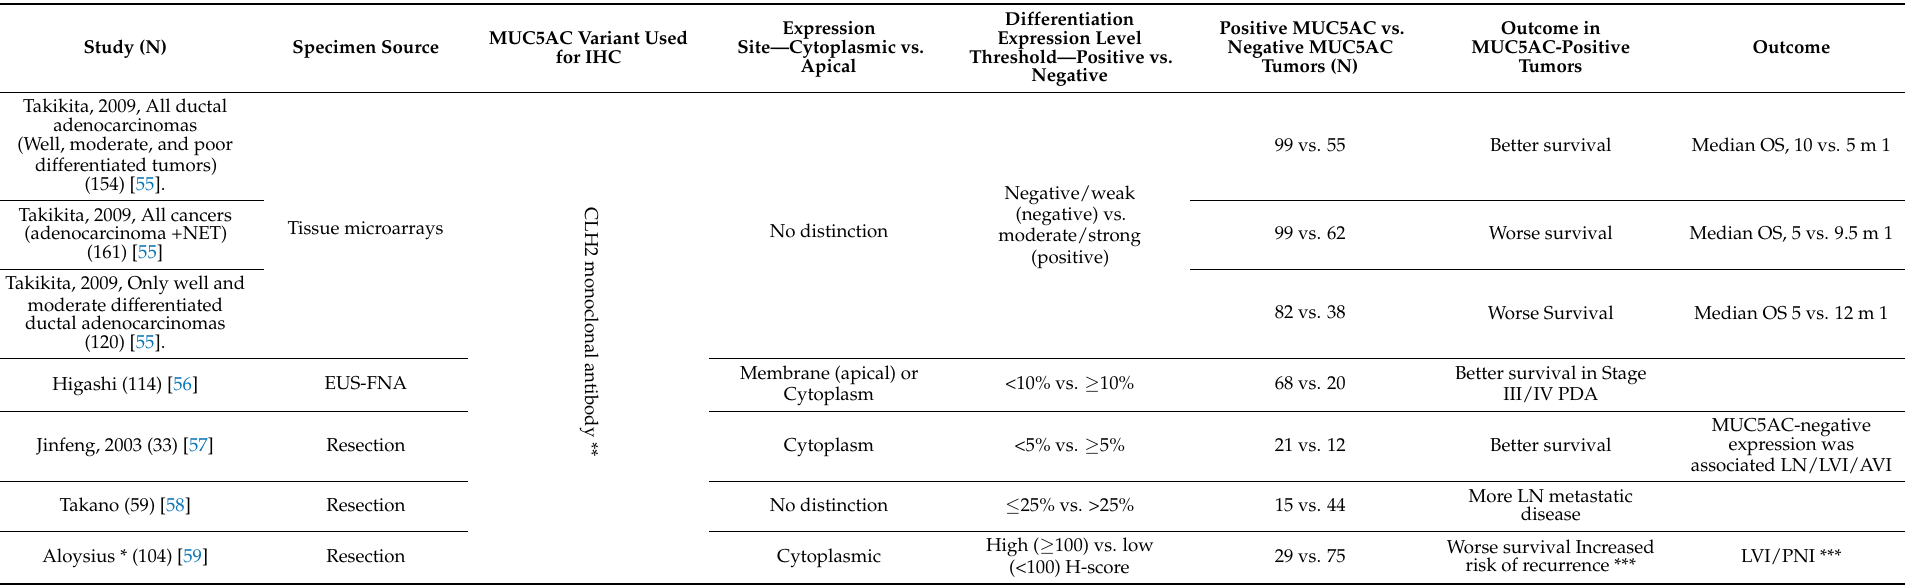
Table 2. Previous studies in pancreatic cancer with MUC5AC and outcomes